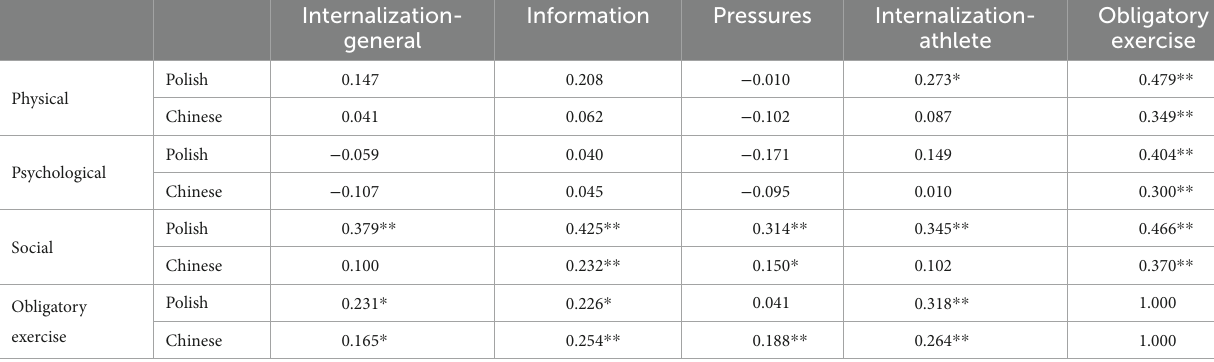
TABLE 2 Correlation analysis for all variables for the groups of Polish and Chinese young